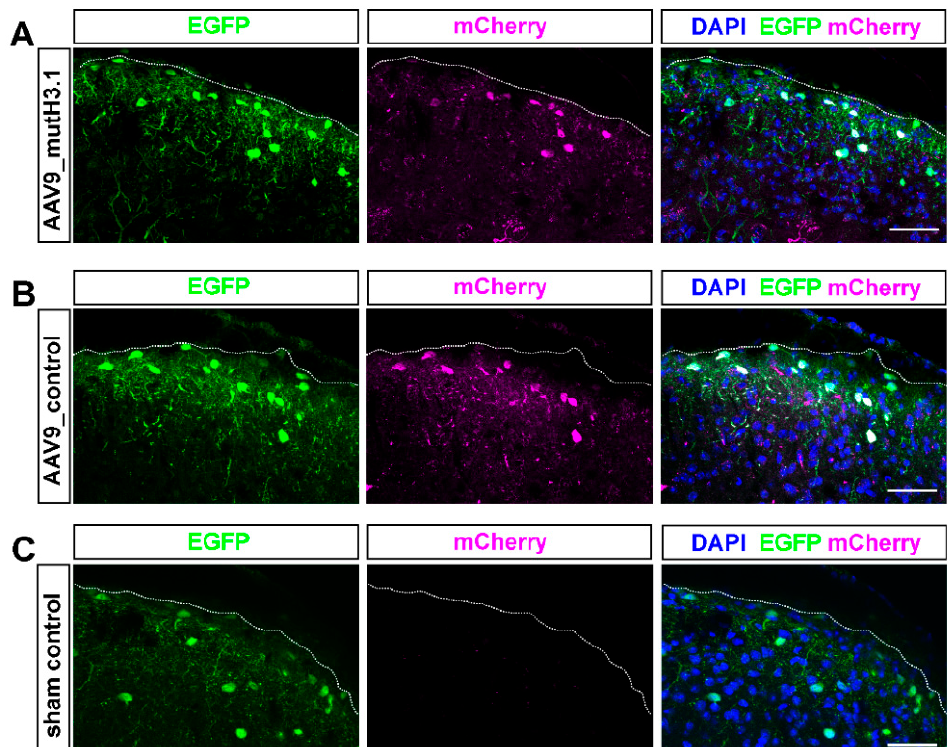
Figure 3. Distribution of AAV9 viral particle in the spinal dorsal horn of Pdyn::cas9-EGFP mice as identified by the presence of mCherry tag encoded by the virus. Representative images showing immunostaining with antibodies against EGFP (green), mCherry (magenta), and DAPI (blue) in projected images of 10 optical sections (each 0.5-µm-thick) taken with a 40× lens in the spinal cord from an AAV9_mutH3.1 vector treated ( A ), an AAV9_control treated ( B ) and a sham-operated ( C ) Pdyn::cas9-EGFP mouse. ( A ) Neurons showing mCherry-immunoreactivity are scattered throughout the SDH. Some Pdyn neurons (green to to their EGFP expression) show strong mCherry signal especially in the superficial region of the dorsal horn. ( B ) Administration of AAV9_control virus into Pdyn::cas9-EGFP mice produced an expression pattern of mCherry, similar to that shown in panel A. ( C ) The mCherry-specific fluorescent signal is completely missing in the transverse spinal cord sections of animals in the sham-operated group. White dotted lines indicate borders between white and gray matter. Scale bars is 50 µm.